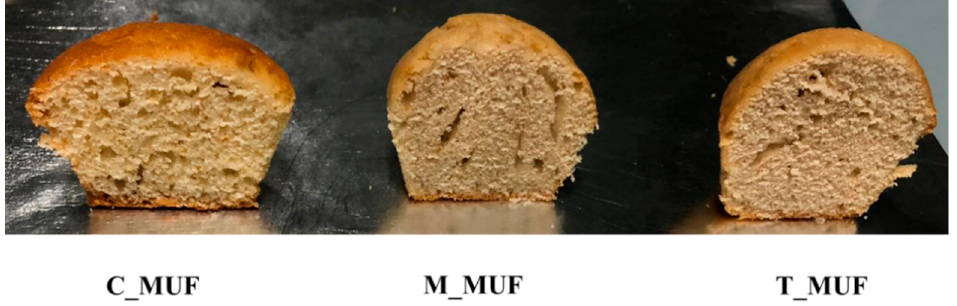
Figure 1. Representative samples of muffins obtained using the new leavening agents (M_MUF,